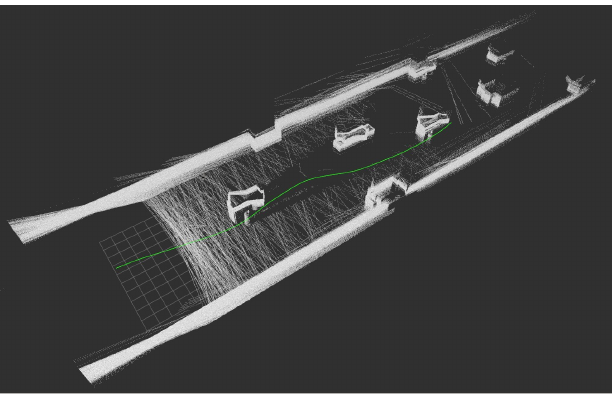
Figure 15. The case when the proposed method fails.